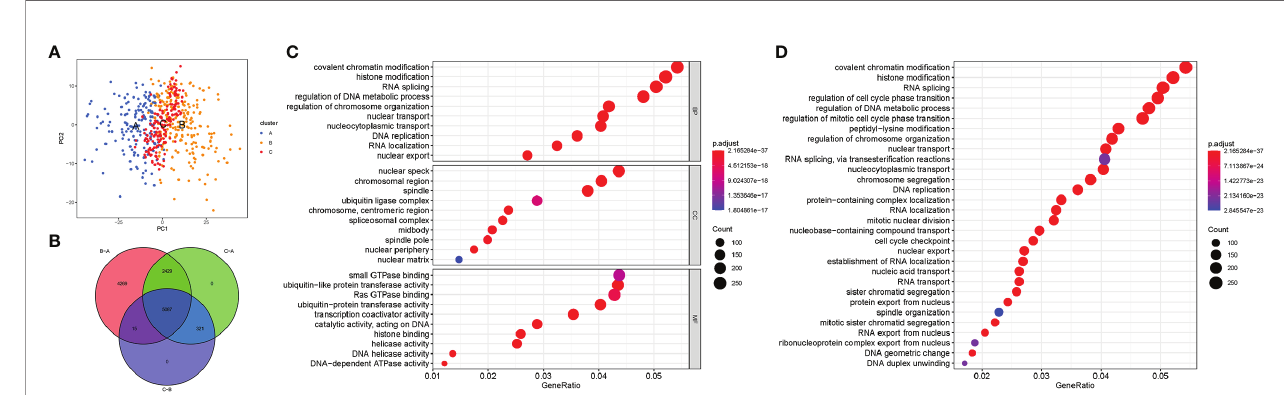
FIGURE 3 | The differential expression of genes in each cluster and the function analysis of co-expressed genes among three clusters. (A) Principal component analysis for the transcriptome pro fi les of cluster A, B, and C; (B) Venn diagram showing the co-expressed genes in the three clusters; (C) GO analysis of the co- expressed genes in three clusters; (D) KEGG analysis of the co-expressed genes in three clusters and the result showed that the co-expressed genes were mainly enriched in pathways related to histone, cell cycle, DNA, and RNA functions.